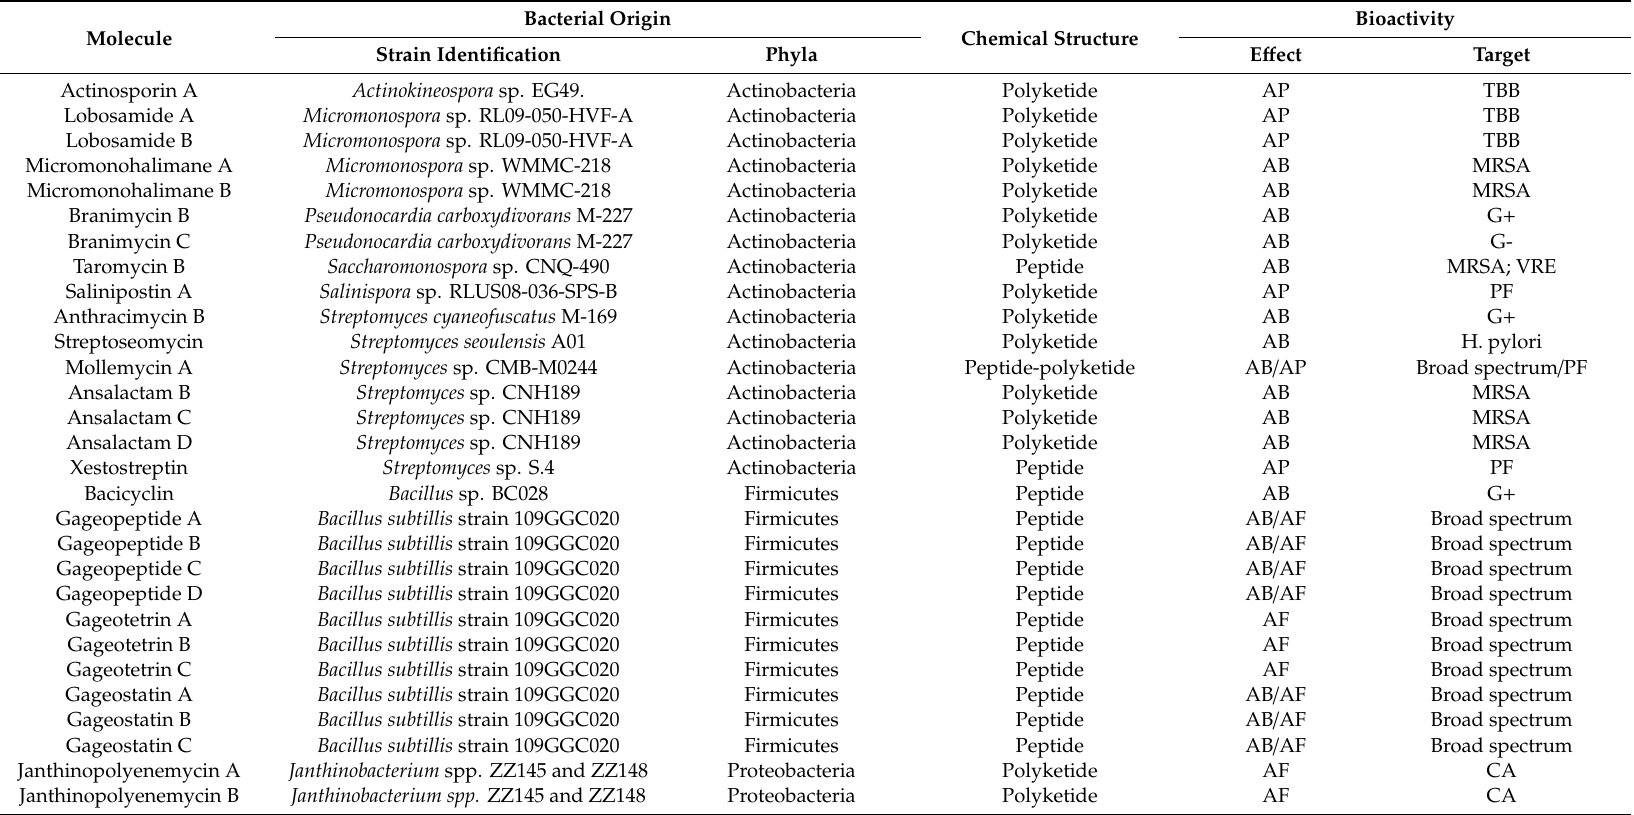
Table 1. Recently isolated bioactive molecules from marine bacteria with antimicrobial properties.